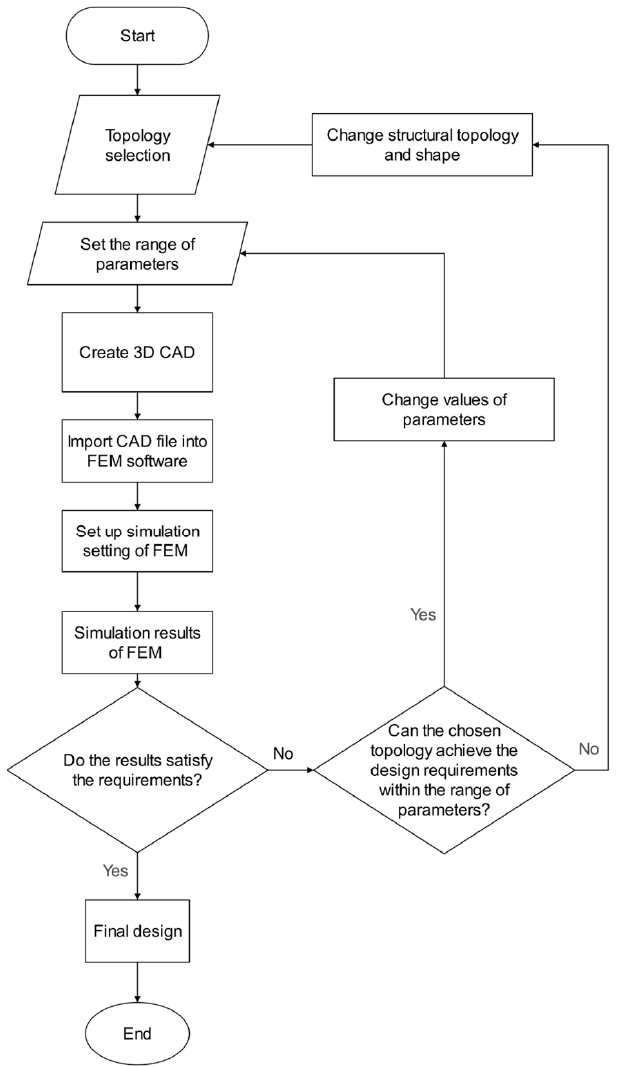
Figure 4. Flowchart of the spring design process.